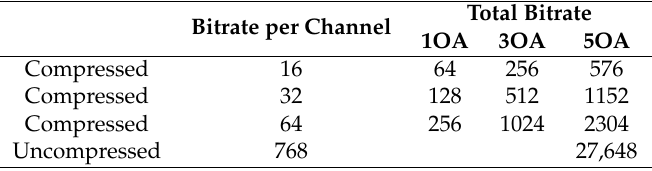
Table 2. Investigated bitrates (kbps) at different Ambisonic